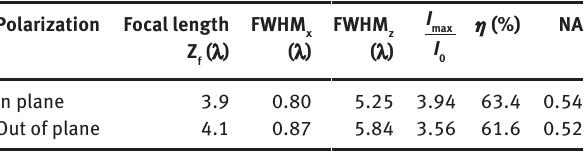
Figure 3: Optical characteristics of the “effective optical lens”. (A) Phase and intensity maps for a pair of rectangles (W = 2 λ , H = λ , n = 1.4, D = 4 λ ). The red arrows represent the Poynting vectors at the entrance, the exit and the focal planes of the effective focal lens (represented by the dashed lens shape). (B) Phase accumulation on the focal axis (x = 0, z) generated by the effective lens. (C) Lateral intensity distribution (black) at focus (x, z = 3.9 λ ) compared with the diffraction limited Airy distribution with numerical aperture NA = 0.64 (red Table 1: Calculated optical characteristics of the microfocusing pattern.